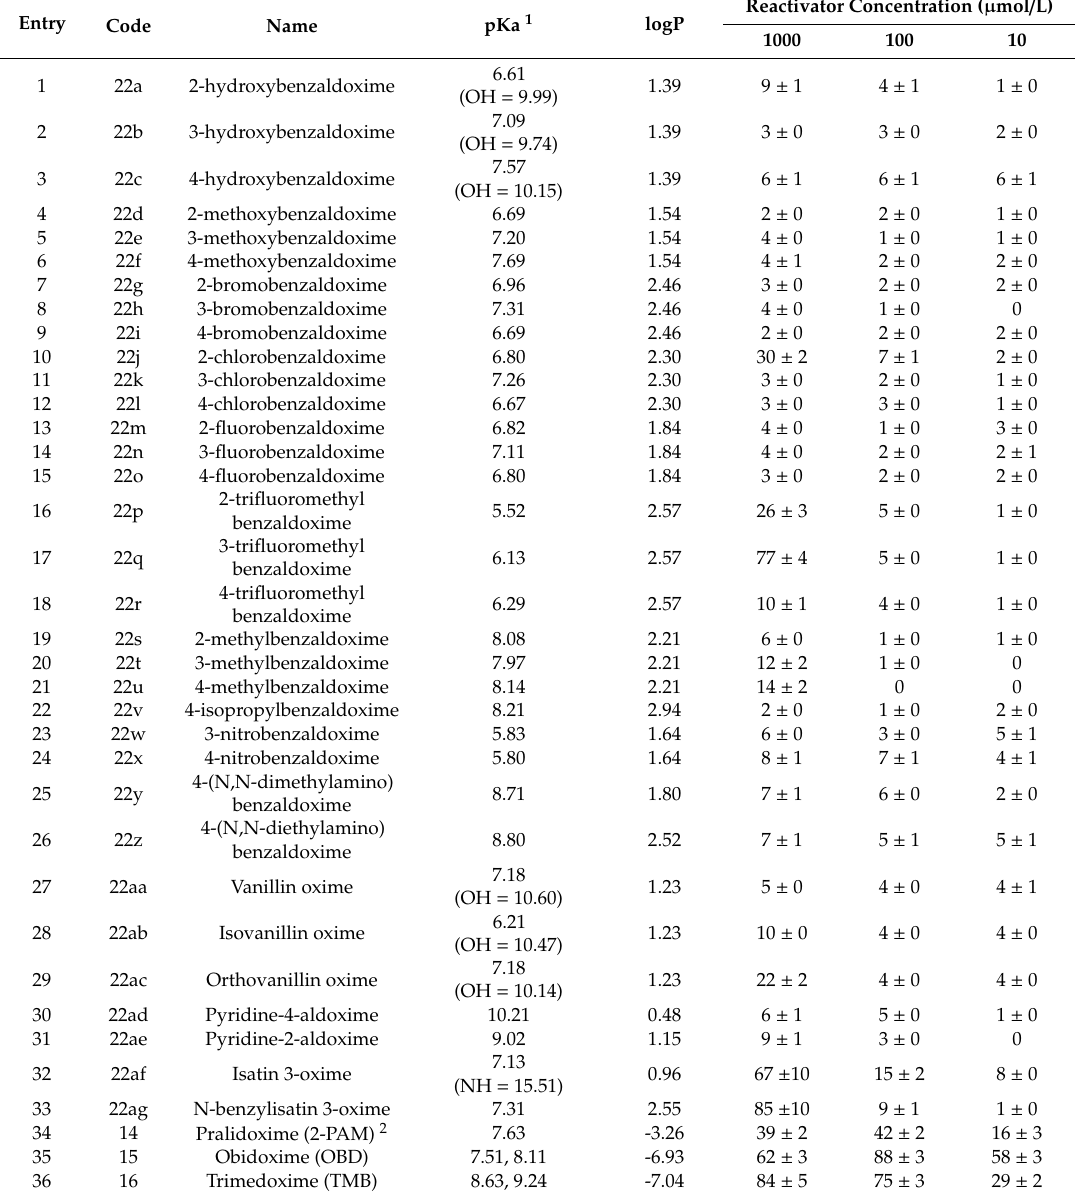
Table 1. Oximes 22a – ag synthesized for assay in this